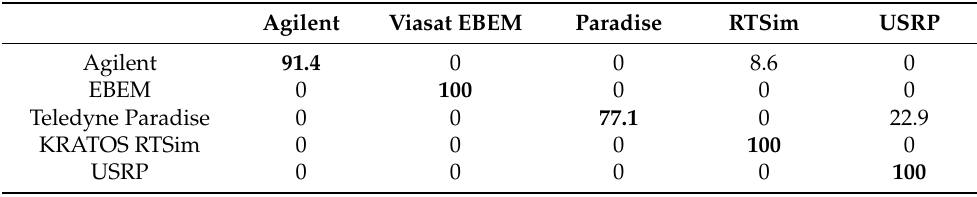
Figure 10. Constellations in SNR = 5 dB noise. Constellation structures have practically disappeared, yet the source identification is still largely possible. Table 2. Five source cross classification rates.